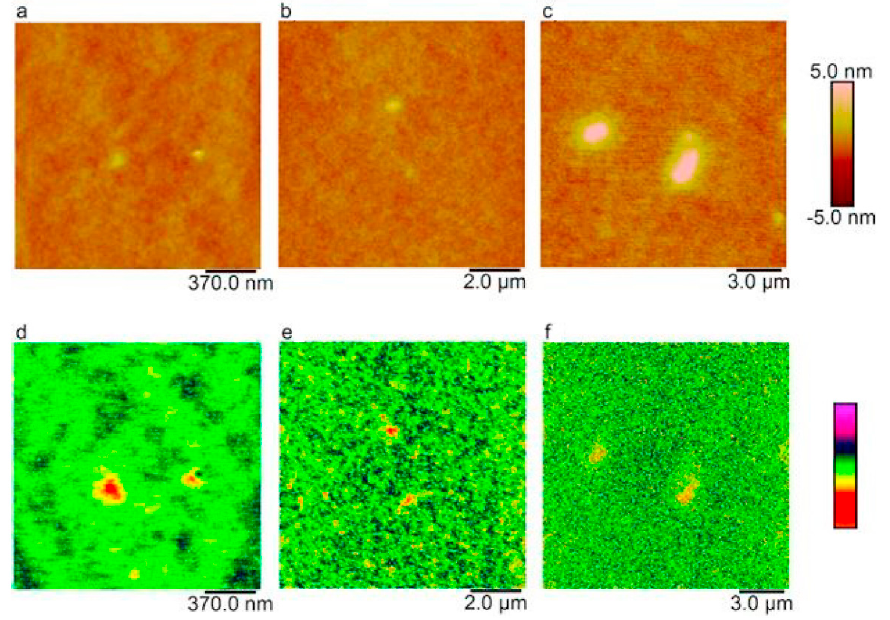
Figure 4. Atomic force and magnetic force microscopy measurements of iron oxide nanoparticles embedded in a resin layer. Topography of 10 nm nanoparticles in a 25 nm layer ( a ), 20 nm nanoparticles in a 150 nm layer ( b ), and 80 nm nanoparticles in a 350 nm layer ( c ). Negative phase shifts due to the attractive magnetic force are observed in corresponding phase images ( d – f ). The color scale is − 1 to 1 ◦ in ( d ), − 0.25 to 0.25 ◦ in ( e ), and − 0.1 to 0.1 ◦ in ( f ). All phase images were taken in 15 nm lift height. These data were reprinted from Ref. [74] with permission from Wiley Online